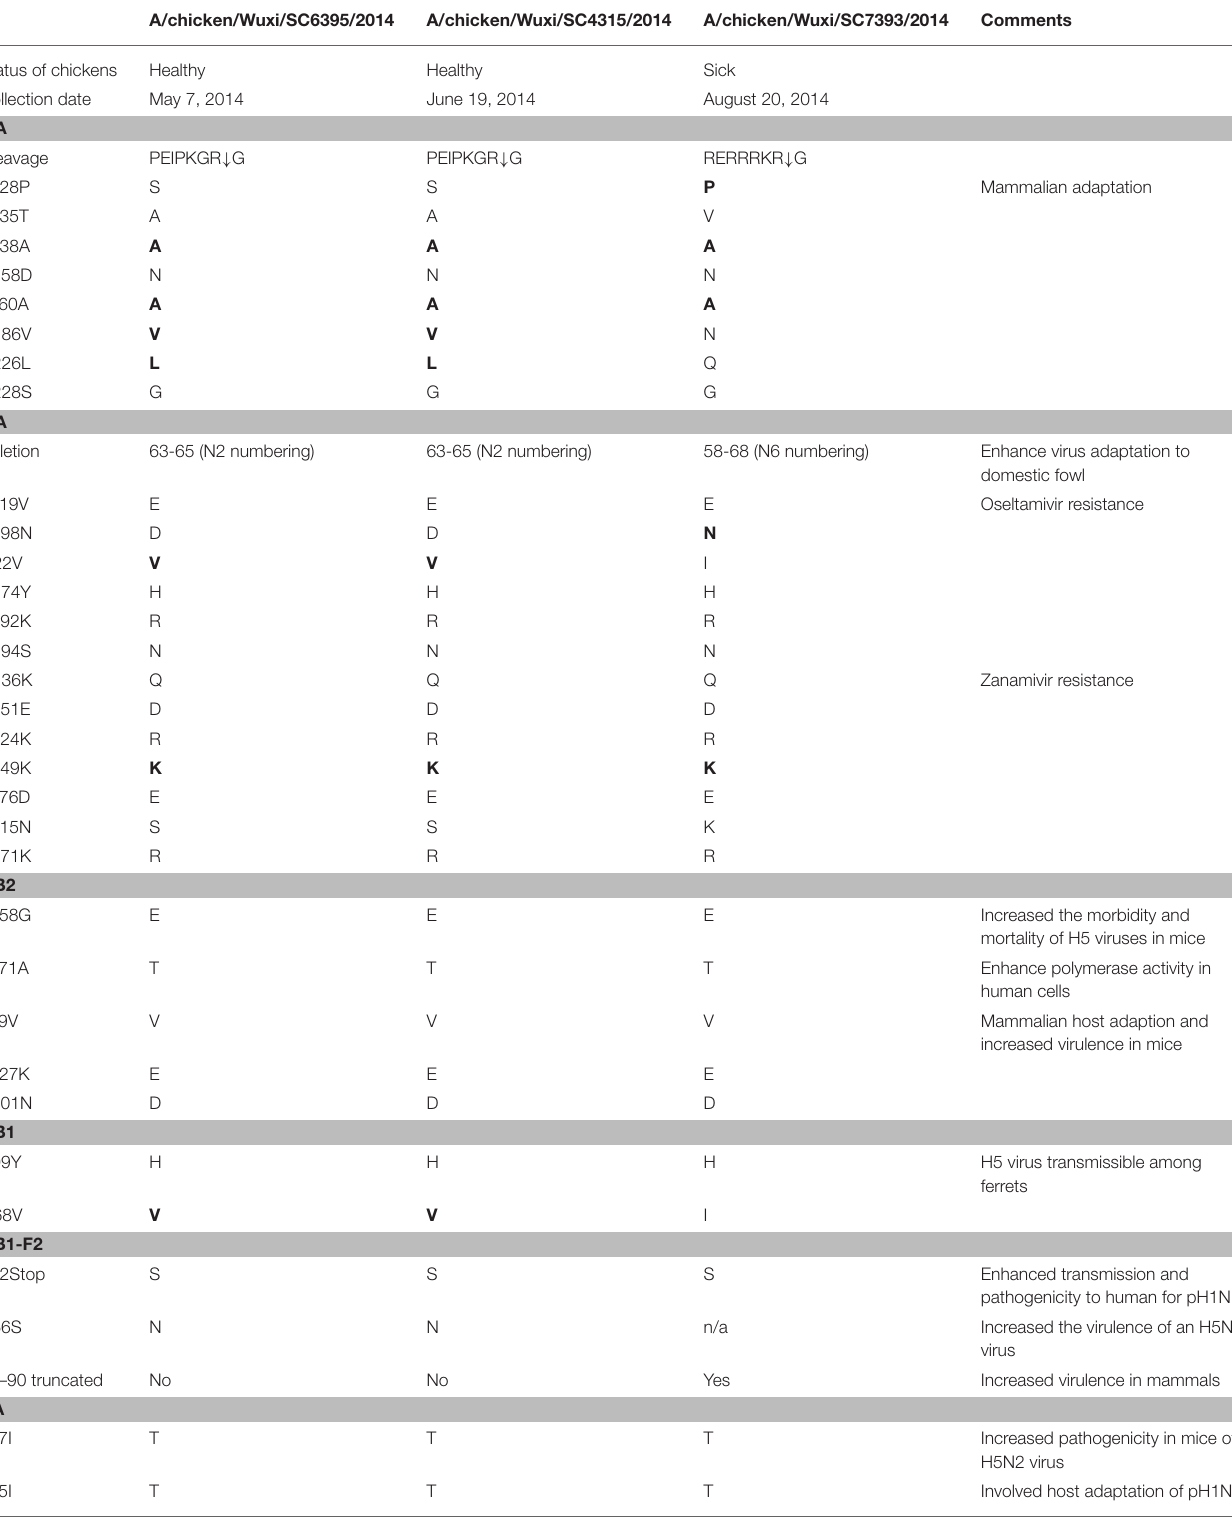
TABLE 2 | Influenza A viruses isolated in present study and mutation analysis of critical amino acid residues associated with virulence, adaptation to mammals or antiviral resistance, Wuxi, China,